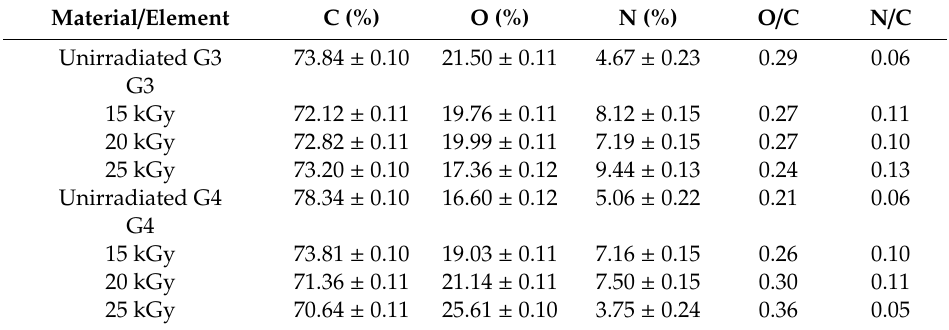
Figure 5. ( a ) Comparative survey spectra for G3 and G4 hydrogels recorded for 20 kGy absorbed dose; ( b ) dependence of O / C ratio as function of the hydrogel type (G3 and G4) and irradiation dose. Table 6. Elemental composition for unirradiated and irradiated G3 and G4 hydrogels as function of absorbed